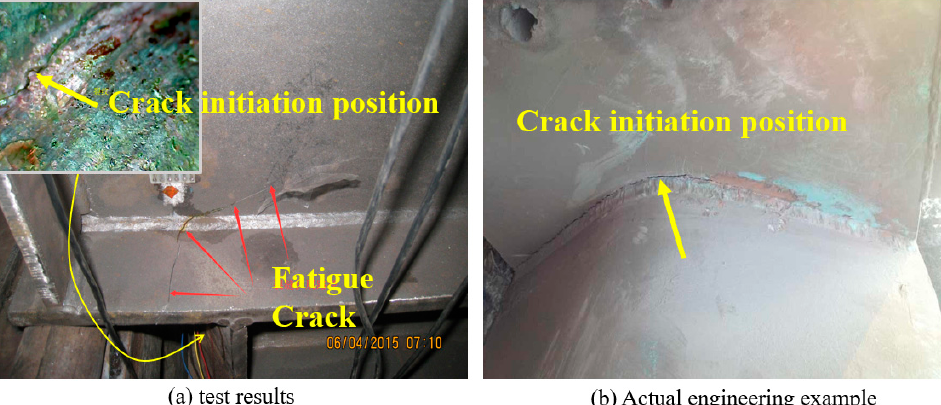
Figure 12. Cracks originated at the weld toe on the plug-in plate.